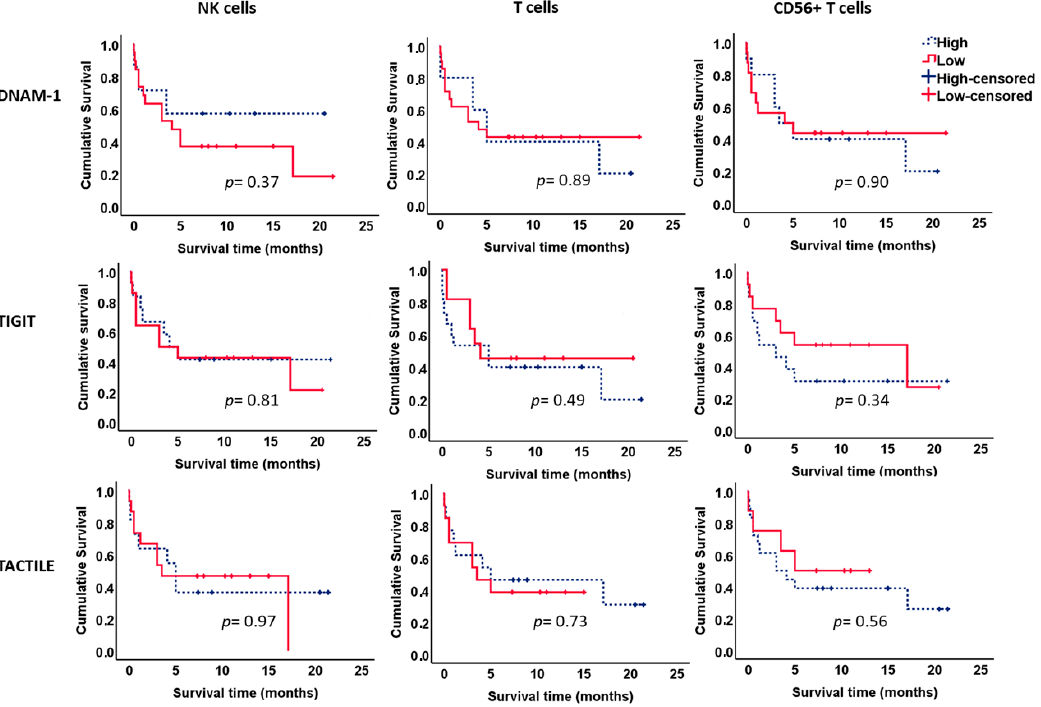
Figure 8. Kaplan–Meier survival analysis in AML patients. AML patients ( n = 26) were stratified according to the expression of DNAM-1, TIGIT and TACTILE on NK cells, CD56 − T cells and CD56+ T cells. ROC curves were used to calculate the optimal cut-off values. Blue dotted lines correspond to patients with high percentage of positive cells for the indicated receptor and red lines to patients with low percentage of positive cells. Censored patients are indicated as tick marks.